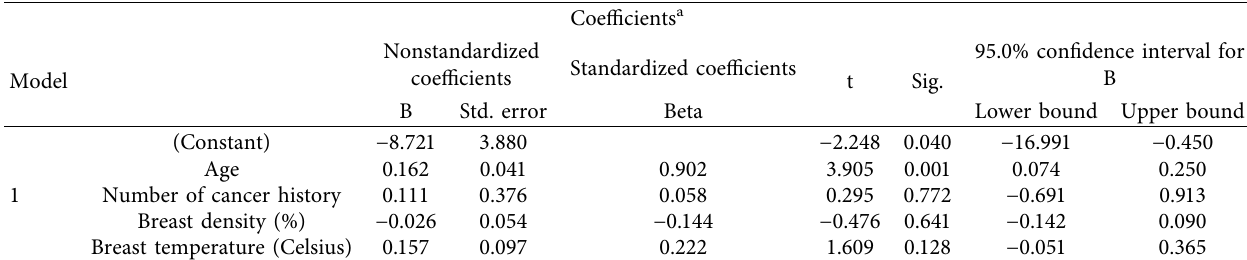
Table 3: Coefficient values of independent variables with relation to the dependent